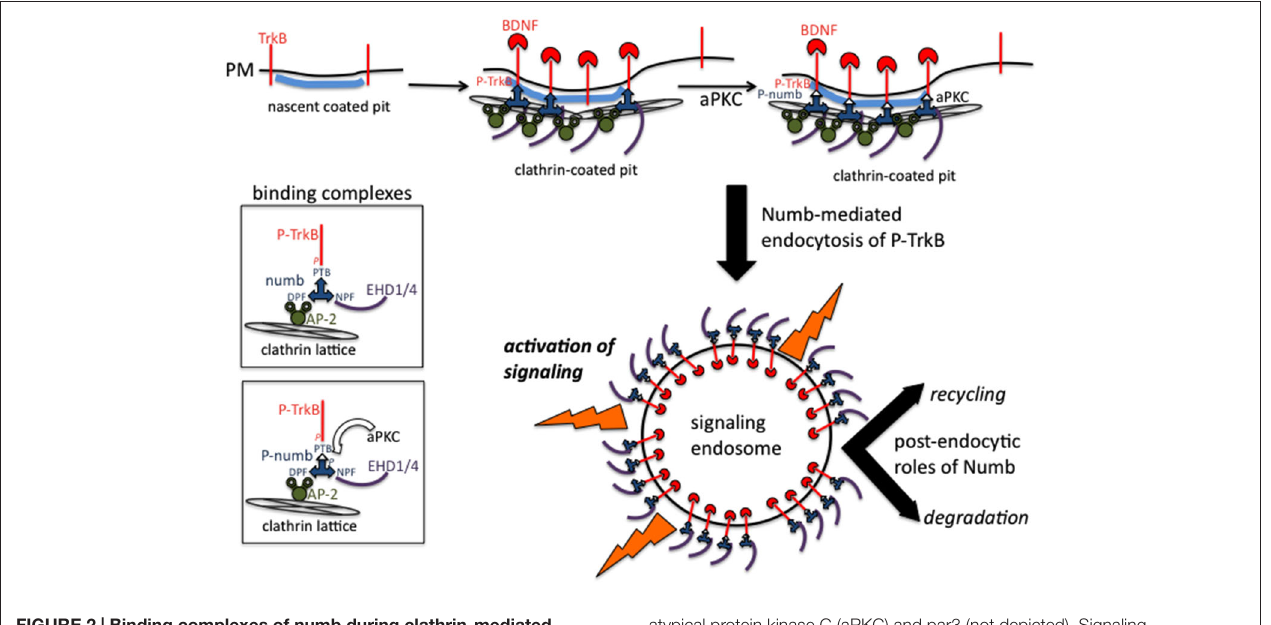
FIGURE 2 | Binding complexes of numb during clathrin-mediated endocytosis of TrkB receptors . Activated TrkB binds to the PTB domain of numb which recruits AP-2, EHD proteins to the forming coated pit. Clathrin is recruited via AP-2 and leads to formation of a clathrin-coated endocytic vesicle. Numb also recruits other signaling effectors such as